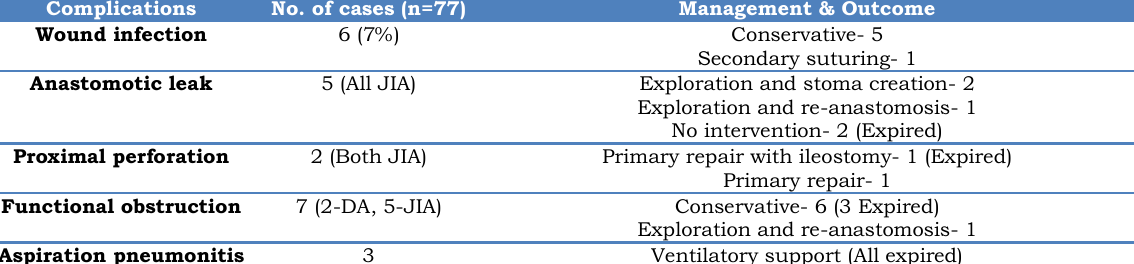
Table 2: Management & outcome of complications in current